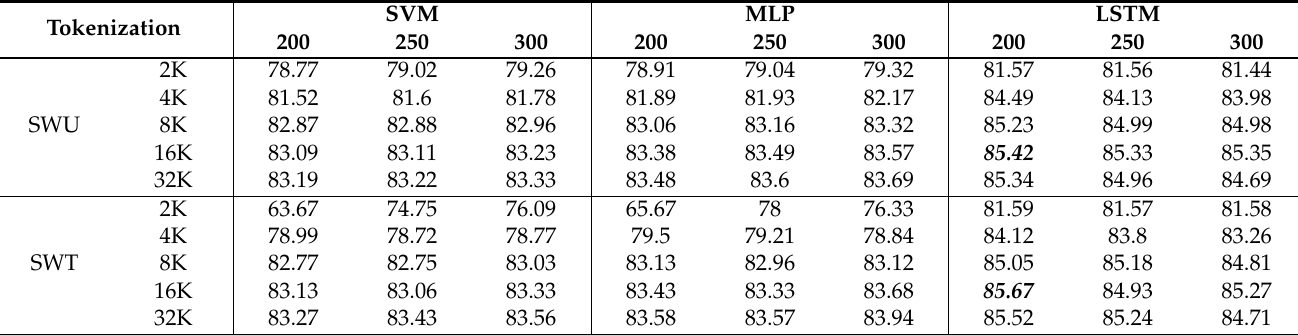
Table 4. Sentiment analysis accuracy with the sentence representation methods based on subword tokenization.